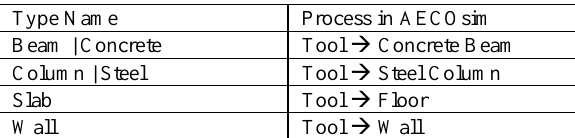
Table 1: Example of the Modelling Process within AECOsim